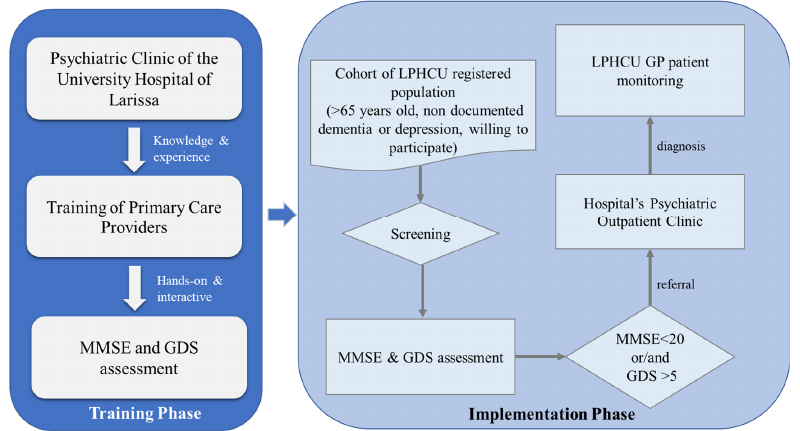
Figure 1. Integration path between the hospital’s Psychiatric clinic and workflow to identify and monitor patients with mental disorders.